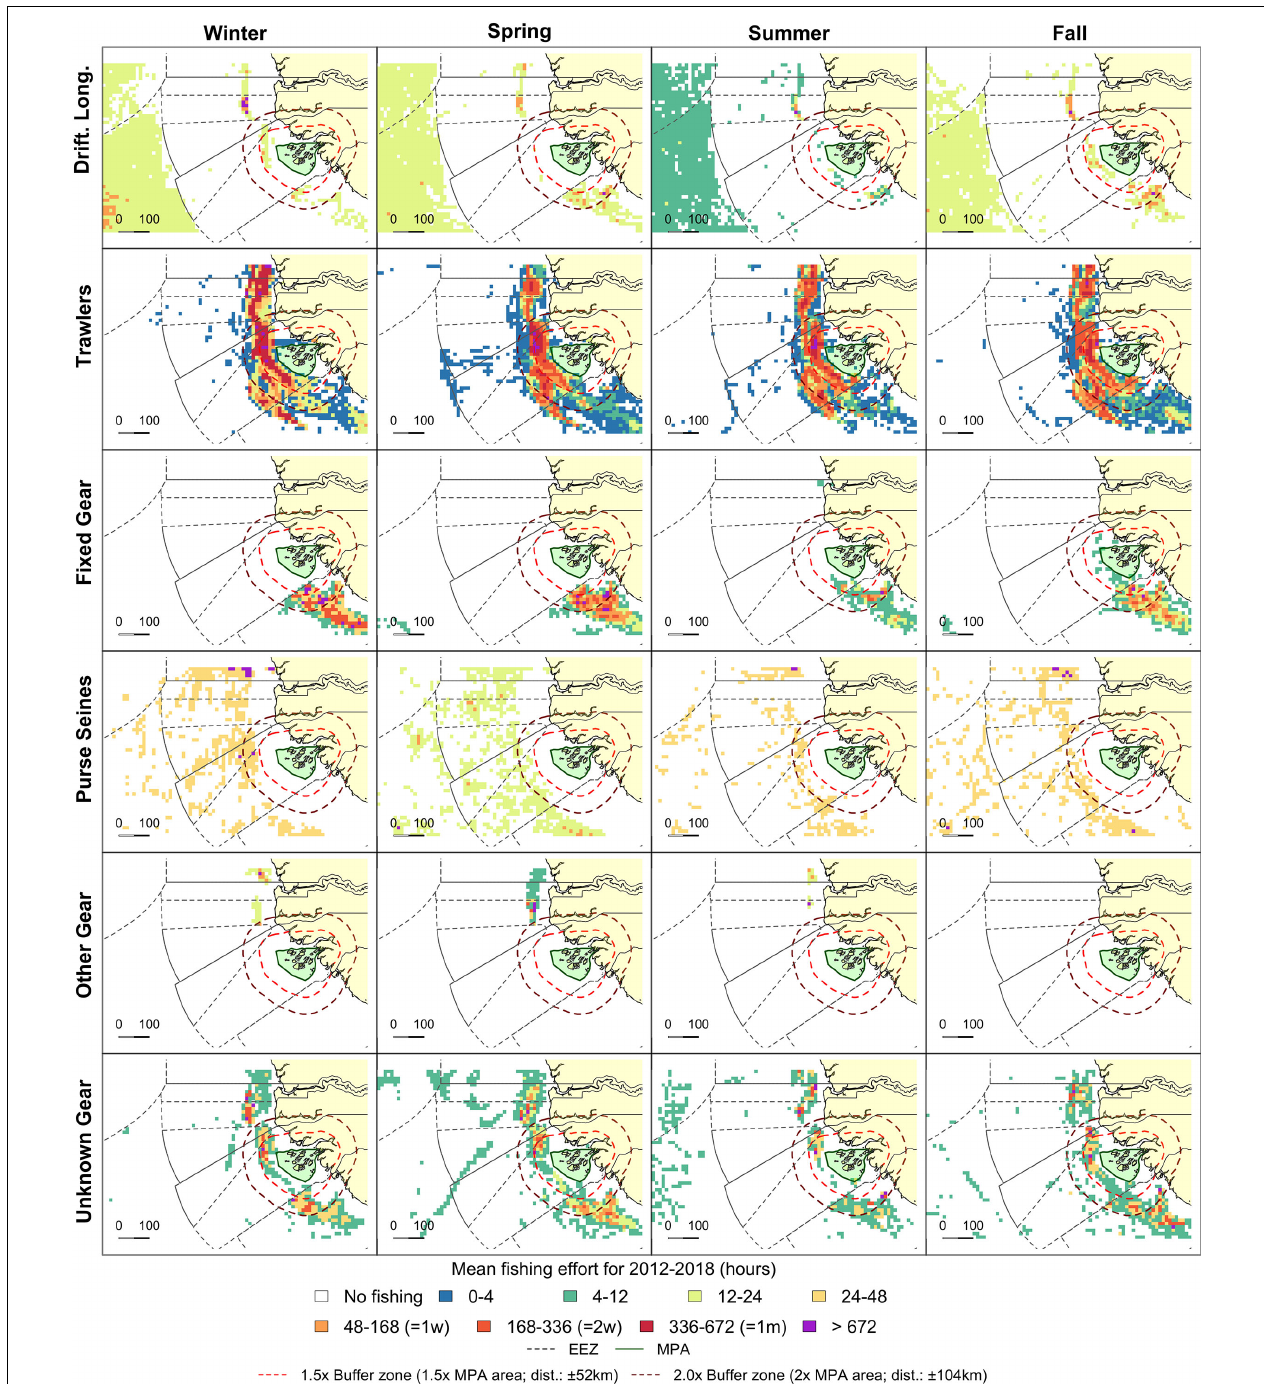
FIGURE 6 | Fishing effort in the direct vicinity of the BA in Guinea Bissau (in green). Grid cell colors represent seasonal mean fishing effort over the 2012–2018 period. Orange and red dashed lines indicate 1.5 and 2.0 buffer zones, respectively. Exclusive Economic Zones (EEZ) are indicated as gray dashed